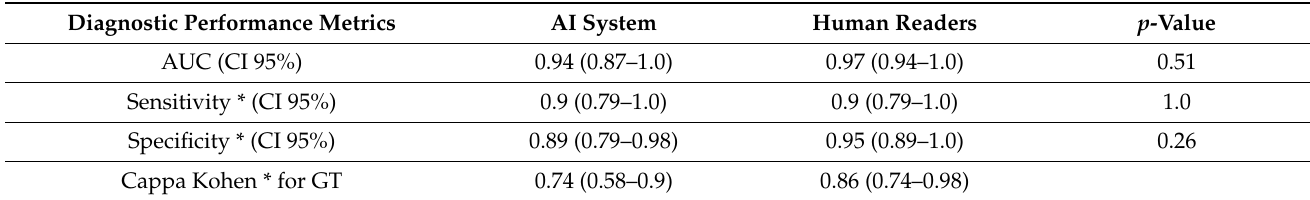
Table 2. The human and AI system diagnostic performance metrics: multi-reader